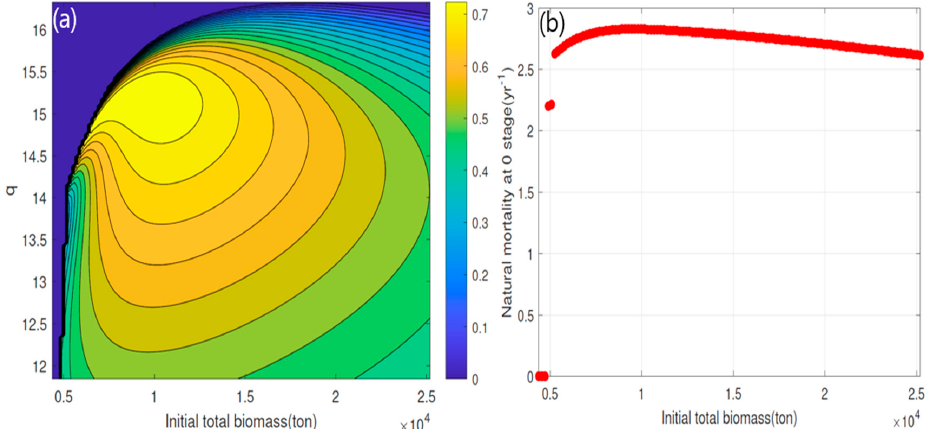
Figure 3. ( a ) Distribution of R 2 for initial total biomass and q; ( b ) M 0 corresponding to maximum R 2 for each initial total biomass.